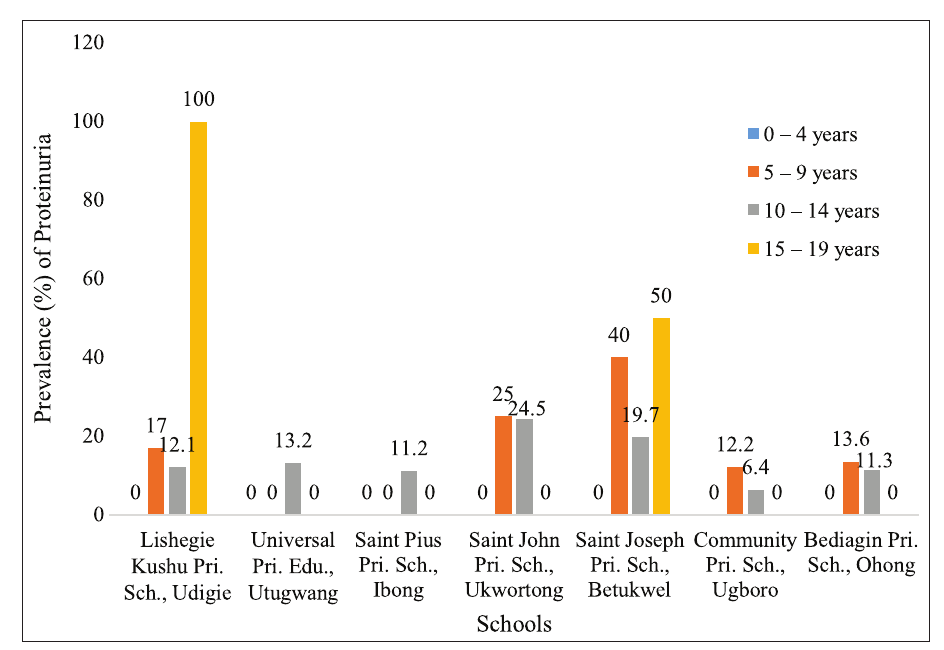
Figure 3: Prevalence of Proteinuria in Relation to Age and School in the Study Table 4: Geometric mean intensity of schistosomiasis infection by age and community in the urine of infected children in obudu L.G.A.